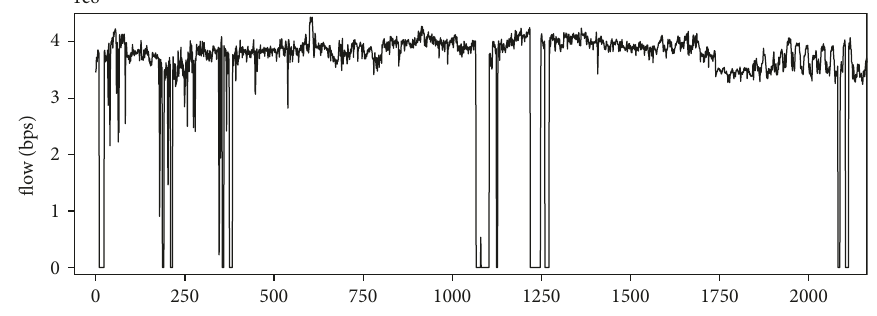
Figure 1: The hourly network